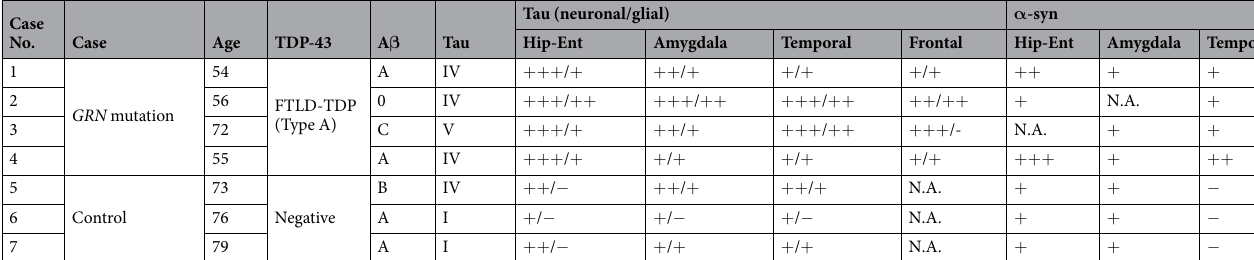
Table 2. Summary of immunohistochemical analyses of the initial study (Study A, No. 1–7). + mild, ++ moderate, +++ severe, − negative, N.A.: not available.